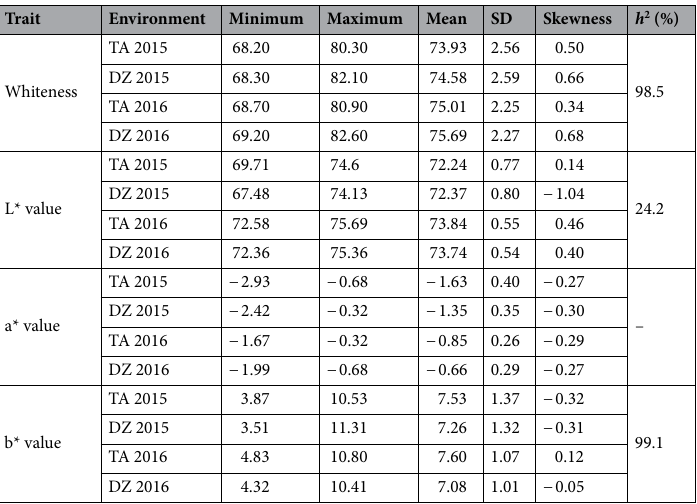
Table 1. Phenotypic analysis of flour whiteness and colour in two locations in 2 years. TA Tai’an location, DZ Dezhou location, L* value the brightness index, a* value the redness index, b* value the yellowness